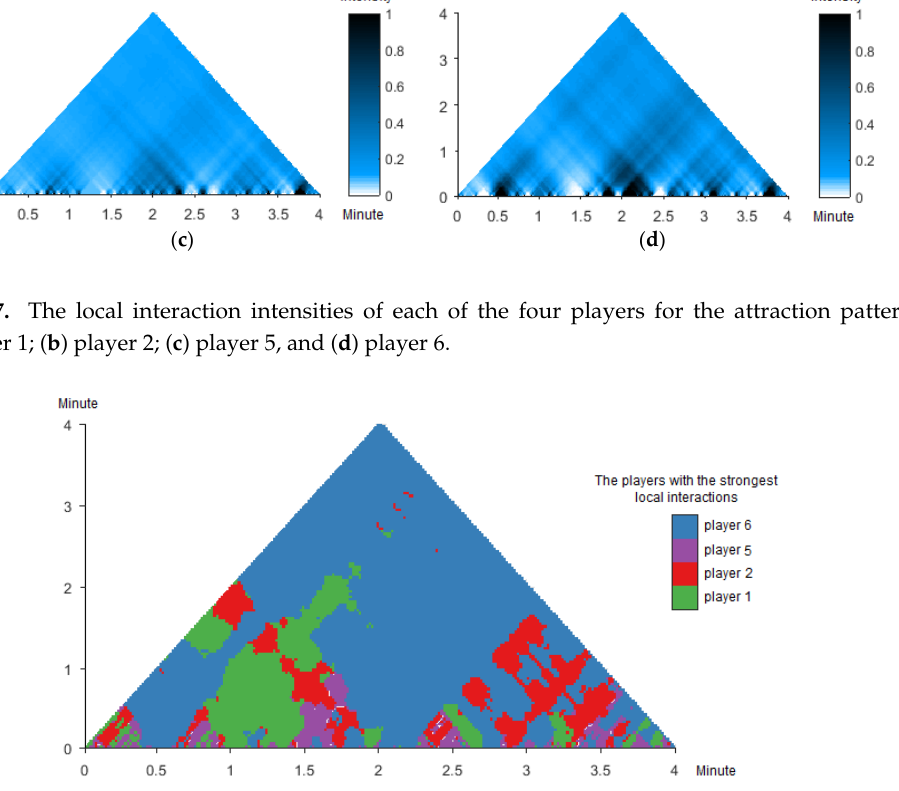
Figure 8. The players which had the strongest local interactions for the attraction pattern.